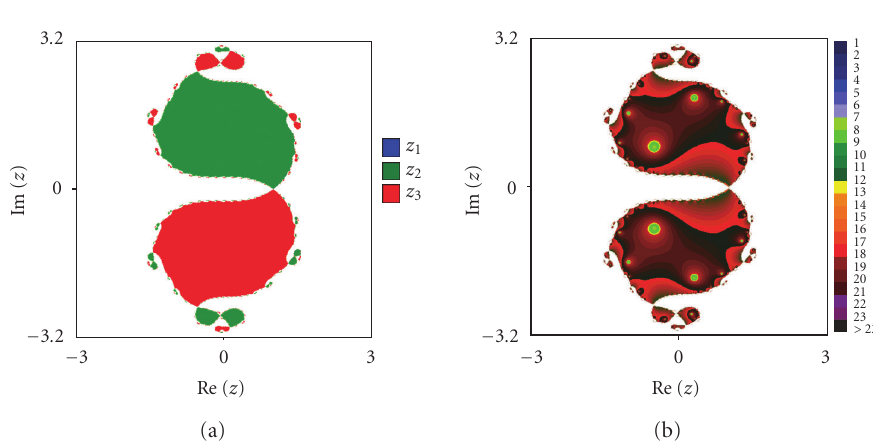
Figure 4.7. Basin of attraction for z 3 − 1 = 0 using GCG method with λ = − 0 . 2 and β = − 0 . 2.